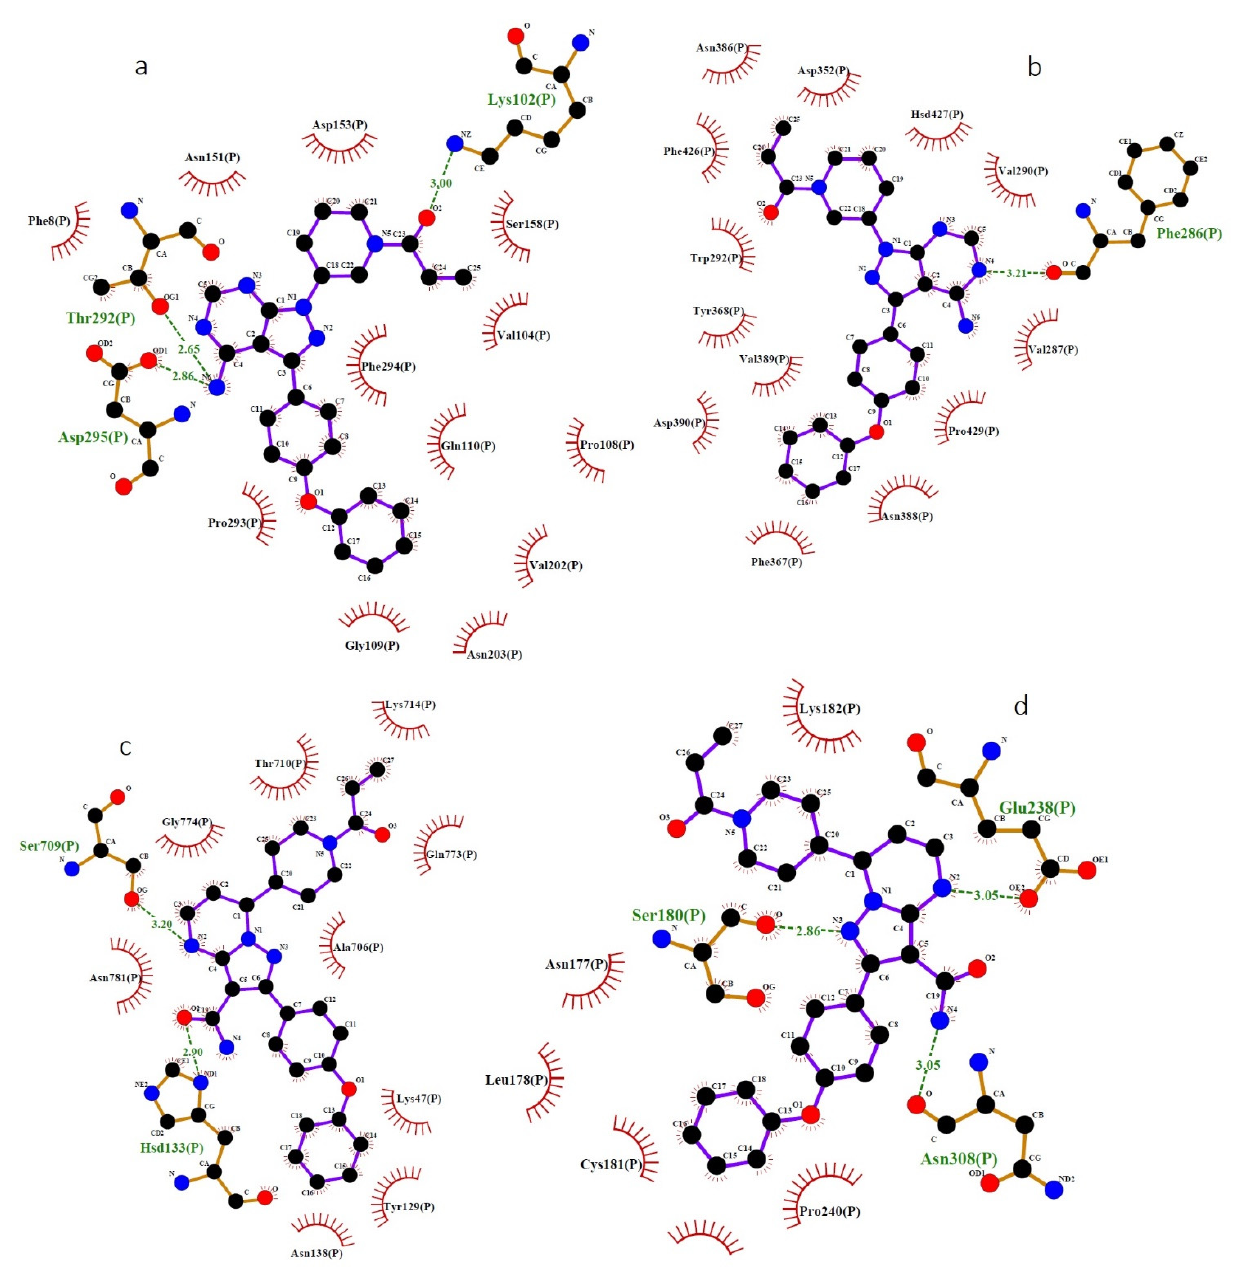
Figure 3. Binding interactions of ibrutinib and zanubrutinib and the nonstructural proteins of SARS-CoV-2 (Mpro, Nsp14, PLpro and RdRp) predicted by LigPlot. ( a ) Interaction of the OG1, OD1, NZ atoms of THR292, ASP295 and LYS102 in Mpro and the N and O atoms of ibrutinib. ( b ) Interaction of the O atom of PHE286 in Nsp14 and the N atom of ibrutinib. ( c ) Interaction of the O, OE2, O atoms of SER180, GLU238, ASN308 in PLpro and the N atom of zanubrutinib. ( d ) Interaction of the ND1, OG atoms of HSD133 and SER709 in RdRp and the O and N atoms of zanubrutinib. Mpro—main protease; RNA-dependent RNA polymerase (RdRp); PLpro—papain-like cysteine protease; blue lines—ligand bonds; orange lines—non-ligand bonds; dotted lines—hydrogen bonds and their length; red semicircles—non-ligand residues involved in hydrophobic contacts; black dots—corresponding atoms involved in hydrophobic contacts.